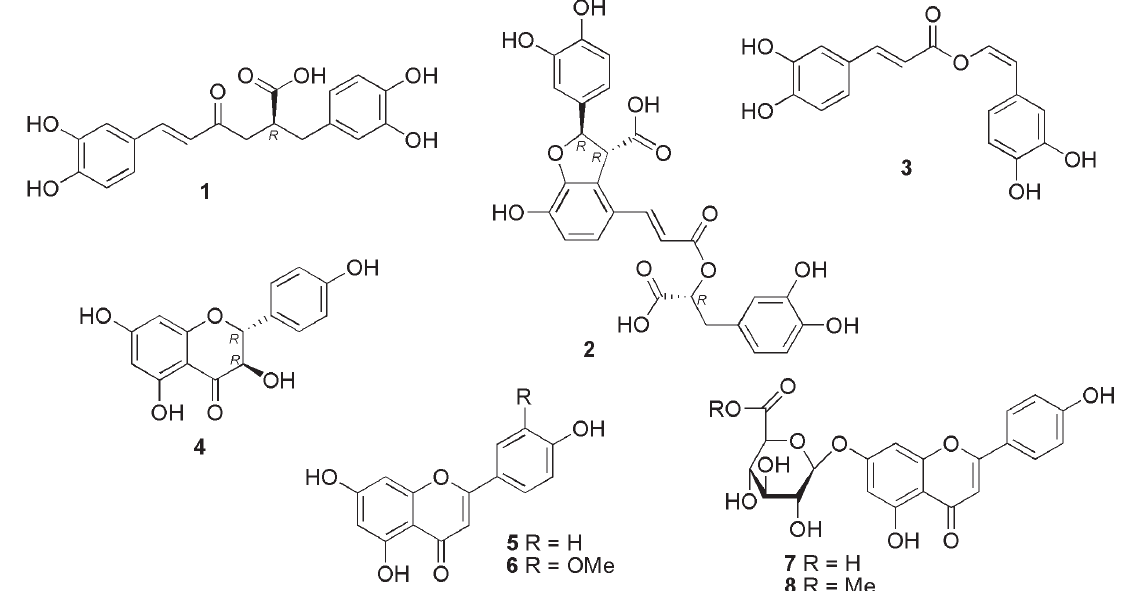
Fig. 1. Chemical structures of compounds isolated from Thymus